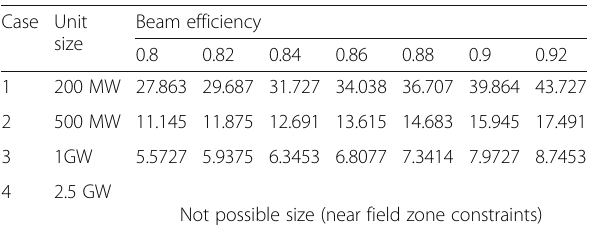
Table 1 Antenna size × 10 5 m 2 at 5.8 GHz with different beam